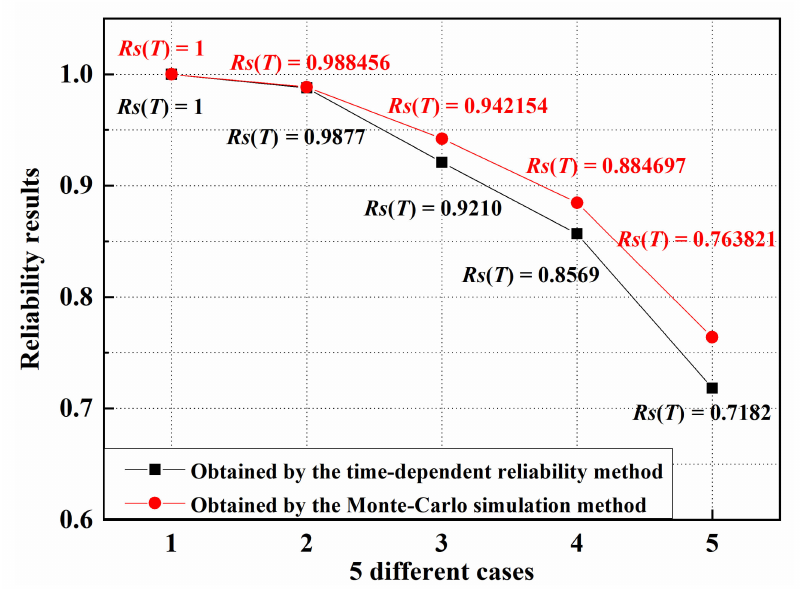
Figure 14. The reliability results comparison of the cantilever beam between the proposed method and the Monte Carlo